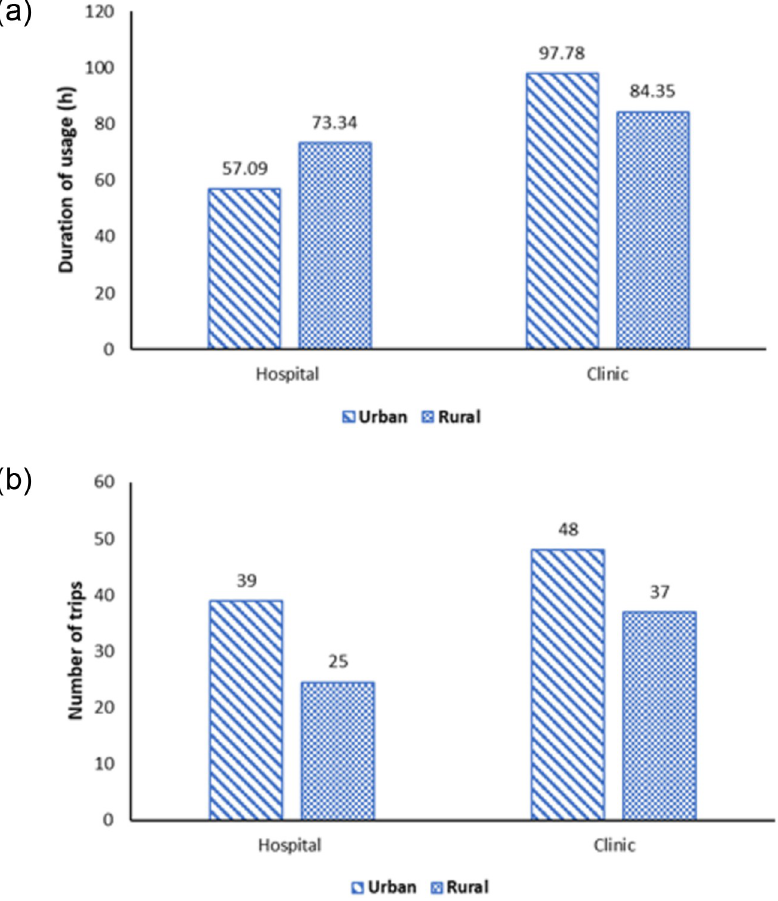
Fig 2. Ambulance utilization per month by ambulance location. A) Mean duration of usage by ambulance location; B) Mean number of trips by ambulance location.